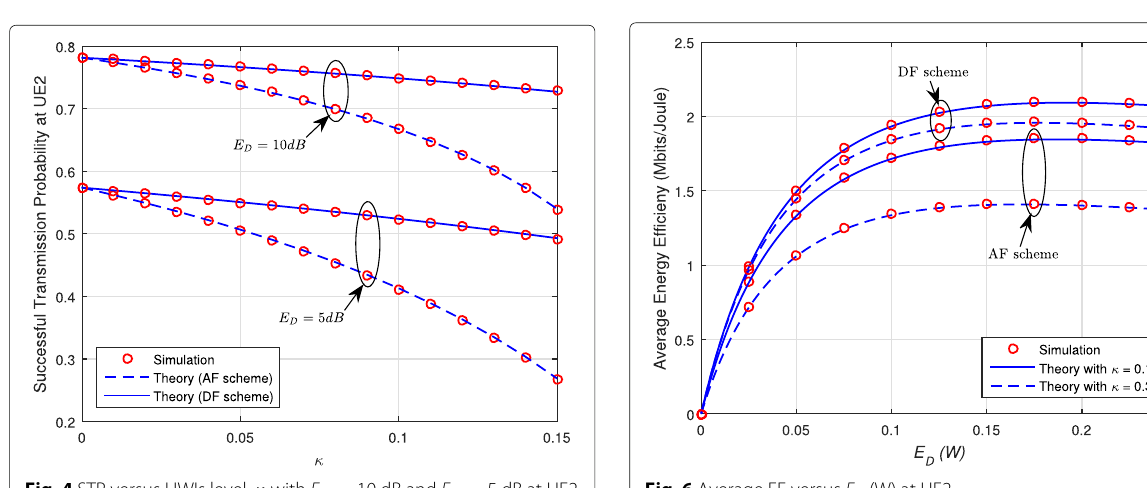
Fig. 4 STP versus HWIs level, κ with E D = 10 dB and E D = 5 dB at UE2